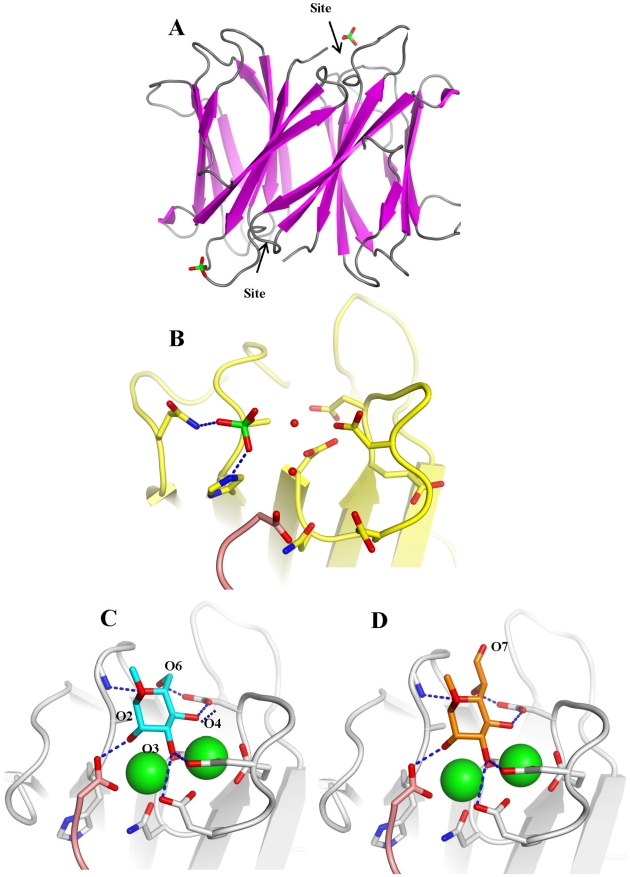
Crystal structure of apoBC2L-C C-terminal domain.A. Dimeric organisation of apo-BC2L-C-Ct, the protein is represented as ribbon. The sulphate ion close to one of the calcium and monosaccharide binding site is represented as sticks. B. Open conformation of the binding site in the absence of calcium and ligand. The sulphate ion interacts with Gln204, His177 and water molecules. C. Molecular modelling of BC2L-C-Ct in complex with calcium and α-methyl-mannoside with rearrangement of binding amino acids. D. Model of the complex with α-methyl-heptoside.